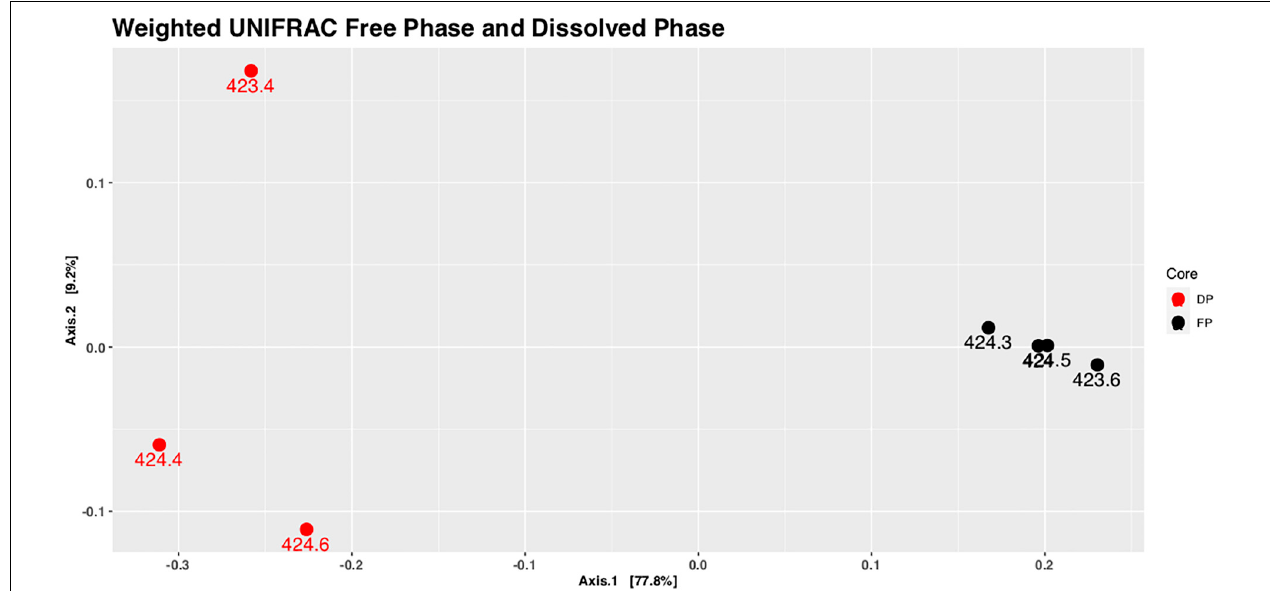
FIGURE 5 | Principal coordinate analysis (PCoA) plot of weighted UniFrac distances of samples taken from the water table in the free-phase oil zone (core 1407; FP, black) and from the water table in the dissolved-phase plume (core 1411; DP, red). The dissolved phase samples group separately from the free-phase oil samples using PERMANOVA ( R 2 = 0.767, p = 0.035). The labels for the points denoting the samples from 424.0 to 424.5 m (a.s.l.) of core 1407